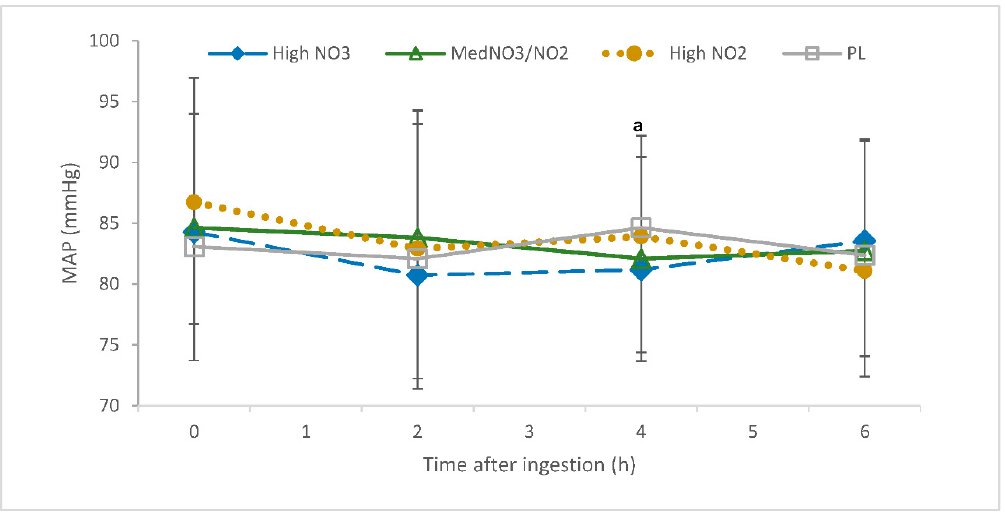
Figure 4. Mean arterial pressure (mmHg) over a 6-h period following the ingestion of placebo (PL); high nitrate, low nitrite (HL); low nitrate, medium nitrite (LM); and medium nitrate and medium nitrite (MM) beverages. a Significant difference between HL and LM p < 0.05).